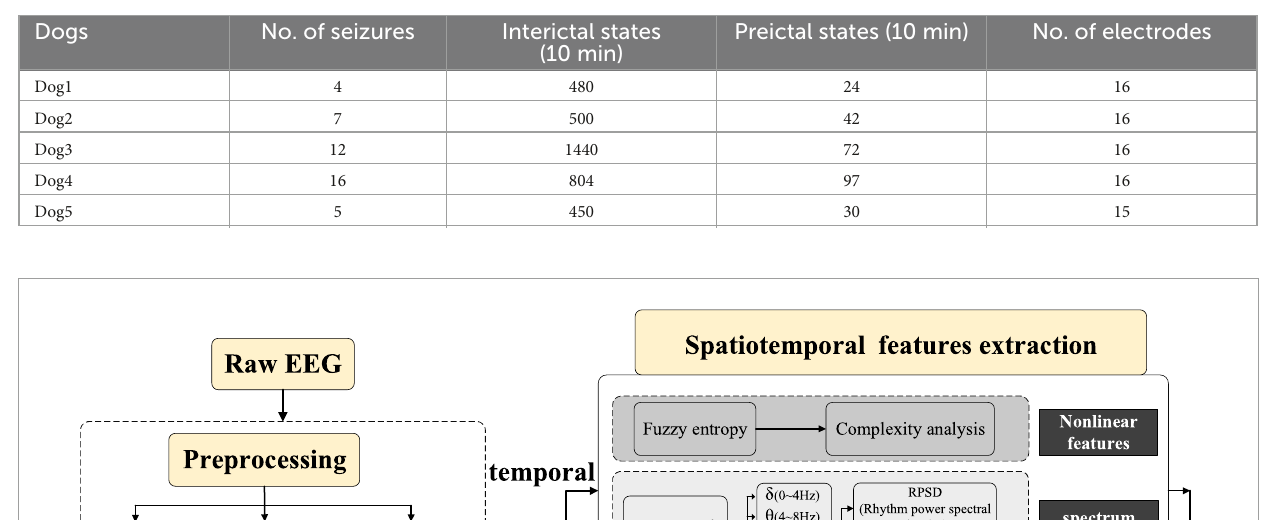
TABLE 2 Information for the canines in the Kaggle competition dataset.